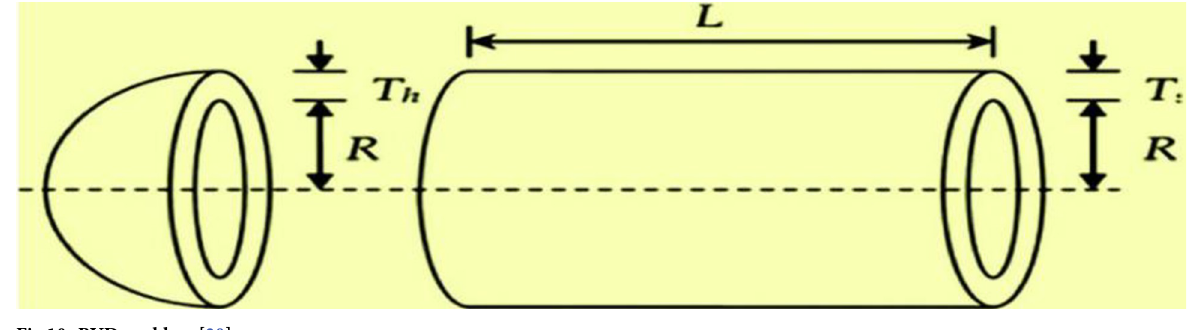
Fig 10. PVD problem